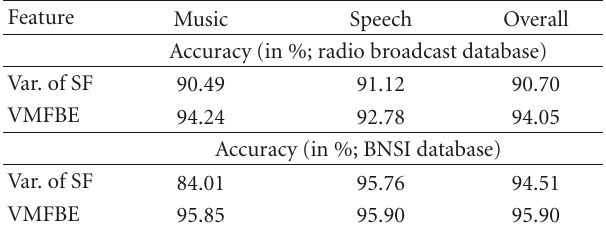
Table 5: Accuracy results for speech/music segmentation, per- formed on BNSI and radio broadcast